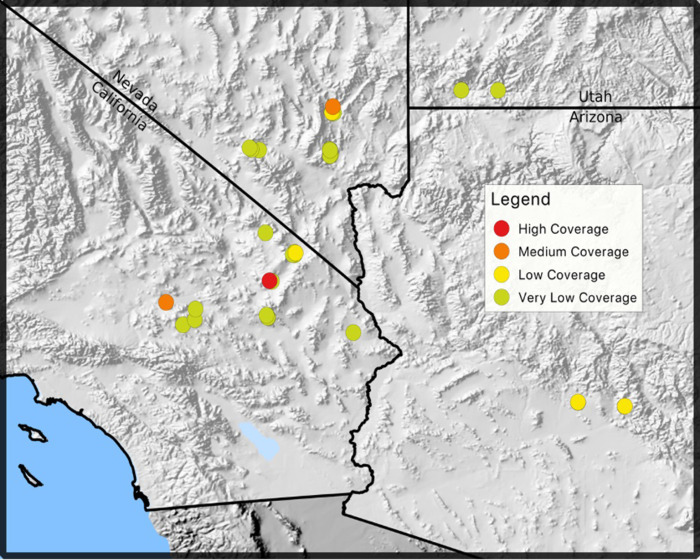
Locations in the Mojave and Sonoran Deserts where Mycoplasma spp. isolates were collected.Locations are color-coded based on genome coverage from next-generation sequencing: high (>40x), medium (>25x), low (>2x), and very low (<2x). The map was created with data from the USGS National Map Viewer.